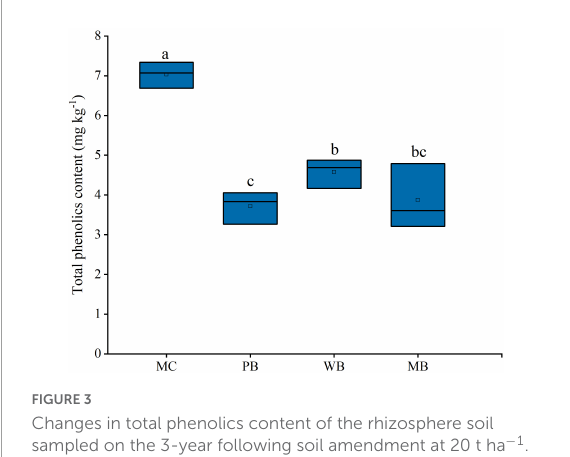
Burkholderia-Caballeronia-Paraburkholderia , Granulicella , Rhodanobacter, and Sphingomonas were decreased by 0.3–3 folds under WB. Under MB compared to MC, however, the abundances of Acidothermuss , Burkholderia- Caballeronia- Paraburkholderia , Candidatus_Solibacter , Gemmatimonas , Granulicella , Phenylo-bacterium , Rhodanobacter, and s . Sphingomonas were decreased by 14% ∼ 3 folds while that n t m e of Candidatus_Udaeobacter increased by